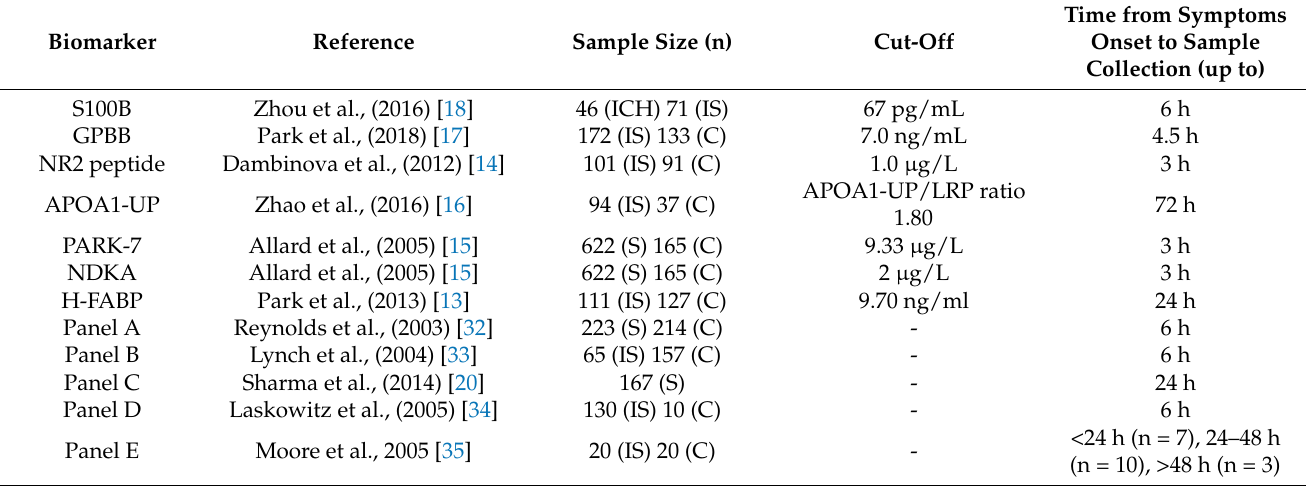
Table 2. Blood biomarkers for stroke